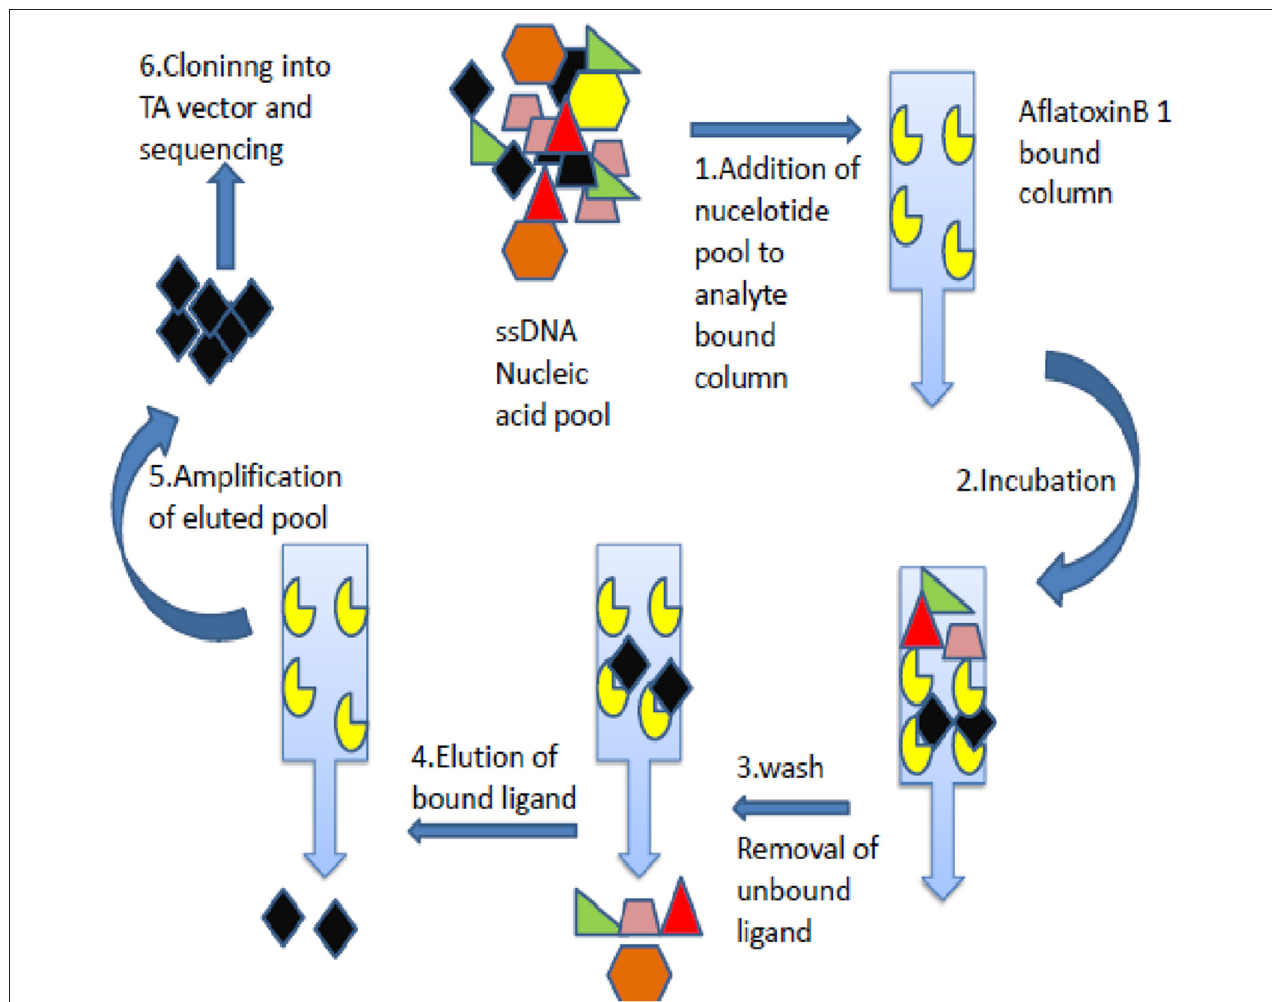
FIGURE 1 | Schematic depiction of aptamers selection procedure. The figure describes Immuno- SELEX (Systematic evolution of ligand by exponential enrichment) technology for AflatoxinB1 specific aptamer generation.